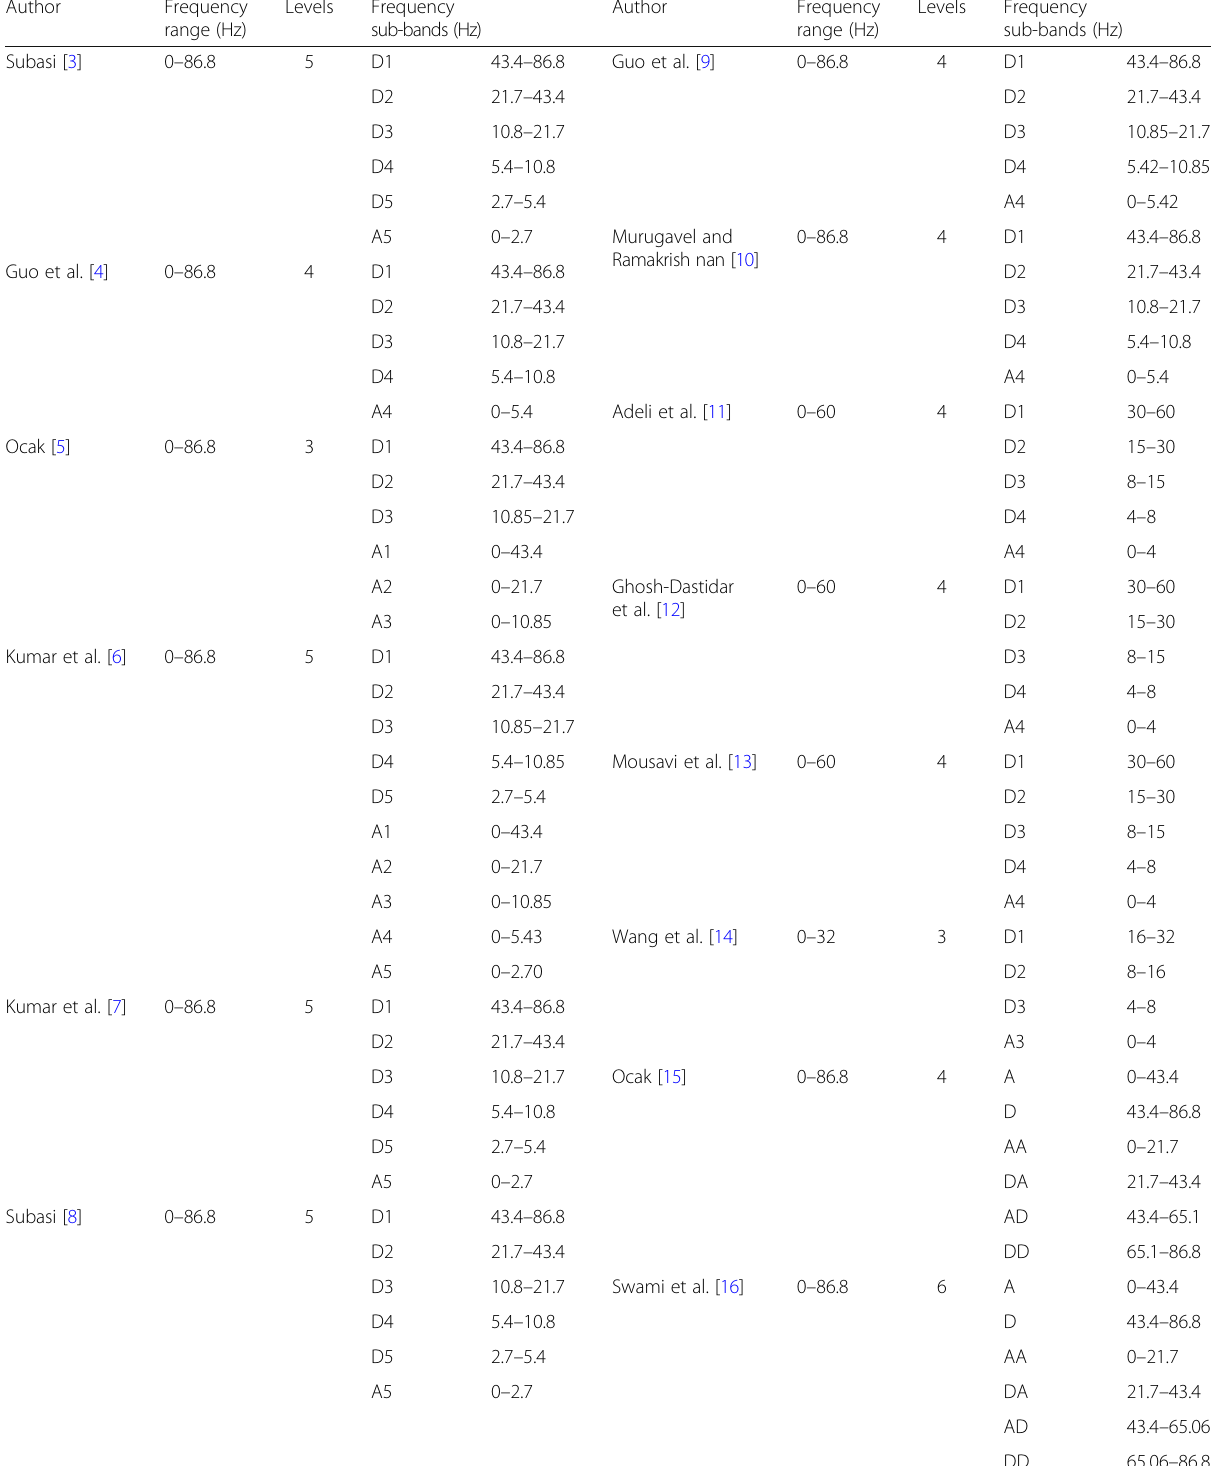
Table 1 WT-based methods for EEG